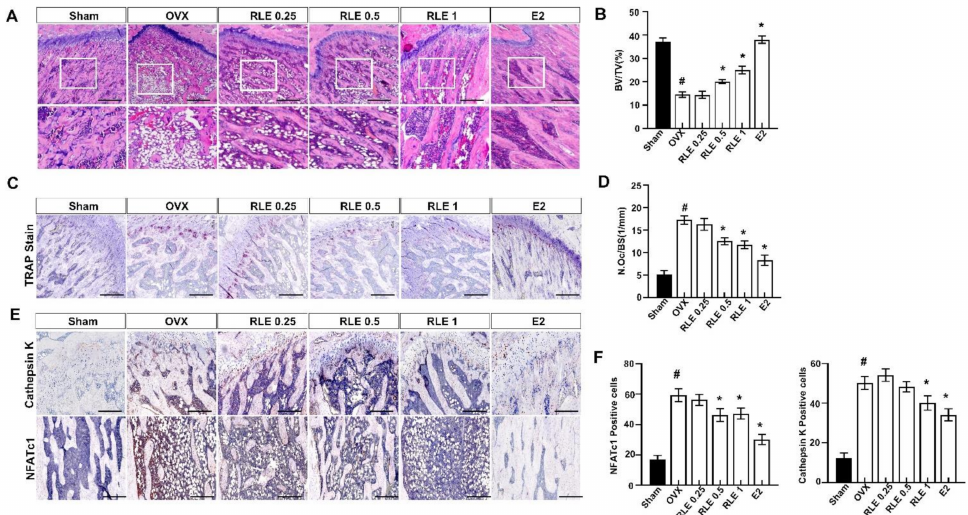
Figure 5. RLE regulates trabecular bone loss in OVX-induced osteoporosis model. H&E and TRAP staining of distal femoral metaphysis regions. ( A ) Representative H&E stained femur bone sections (scale bars is 200 µ m). ( B ) The analysis of BV/TV based on the H&E stained femur bone sections. ( C ) Representative TRAP-stained femur bone. Image J was used to estimate trabecular area and ( D ) osteoclast number per bone surface. ( E ) Representative NFATc1 and cathepsin-K-stained femur bone. ( F ) NFATc1 and cathepsin-K-positive cells were counted and quantified relatively. Data are shown as mean ± SEM. ( n = 10, # p < 0.05 vs. sham; * p < 0.05 vs. OVX). Sham, sham-operated group; OVX, ovariectomy; RLE, Ramie leaf extract; TRAP, tartrate-resistant acid phosphatase; N.oc, osteoclast numbers per bone